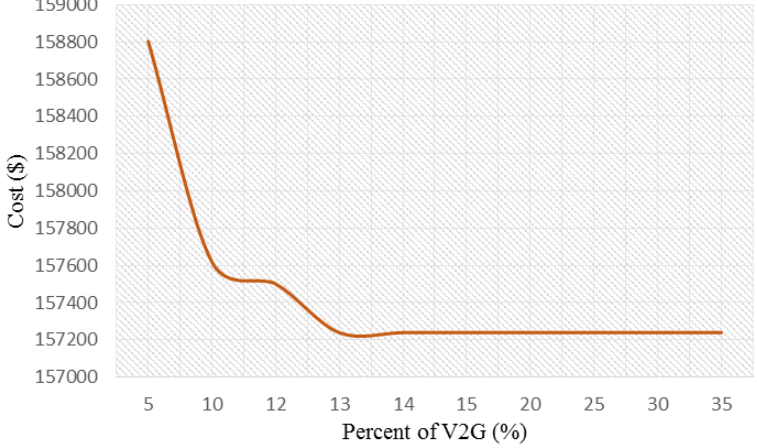
Figure 15. The optimal presence percentage of electrical vehicles in the charging station.